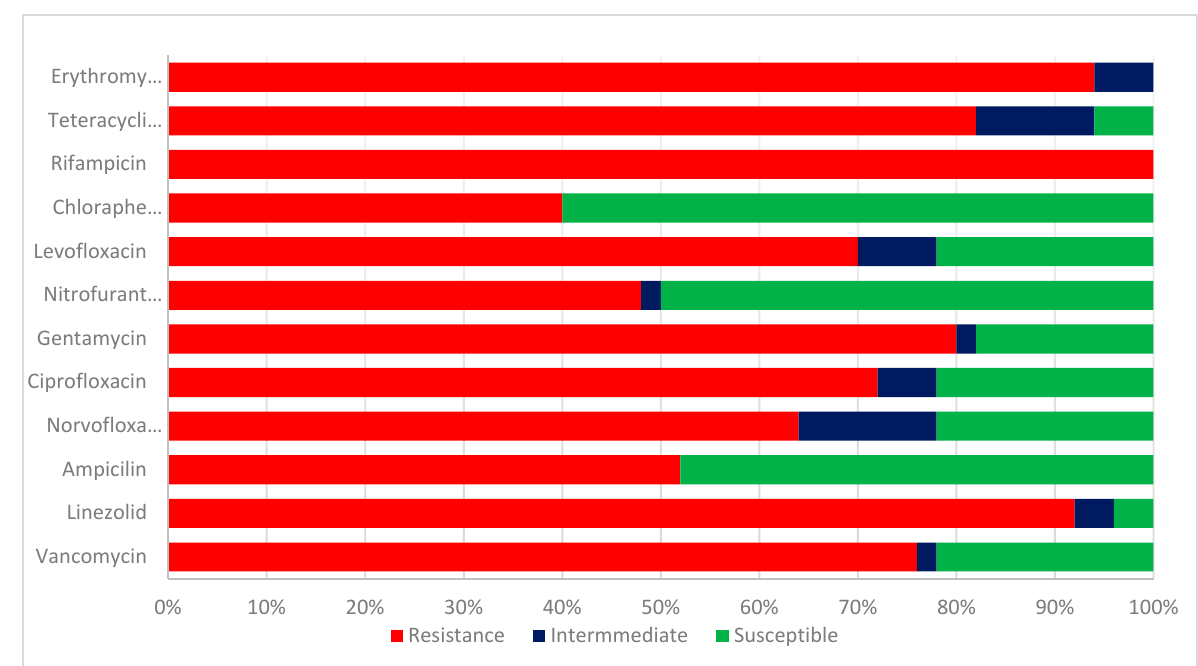
Figure 3. Antibiotic sensitivity pattern of class 1 integron Enterococcus species.